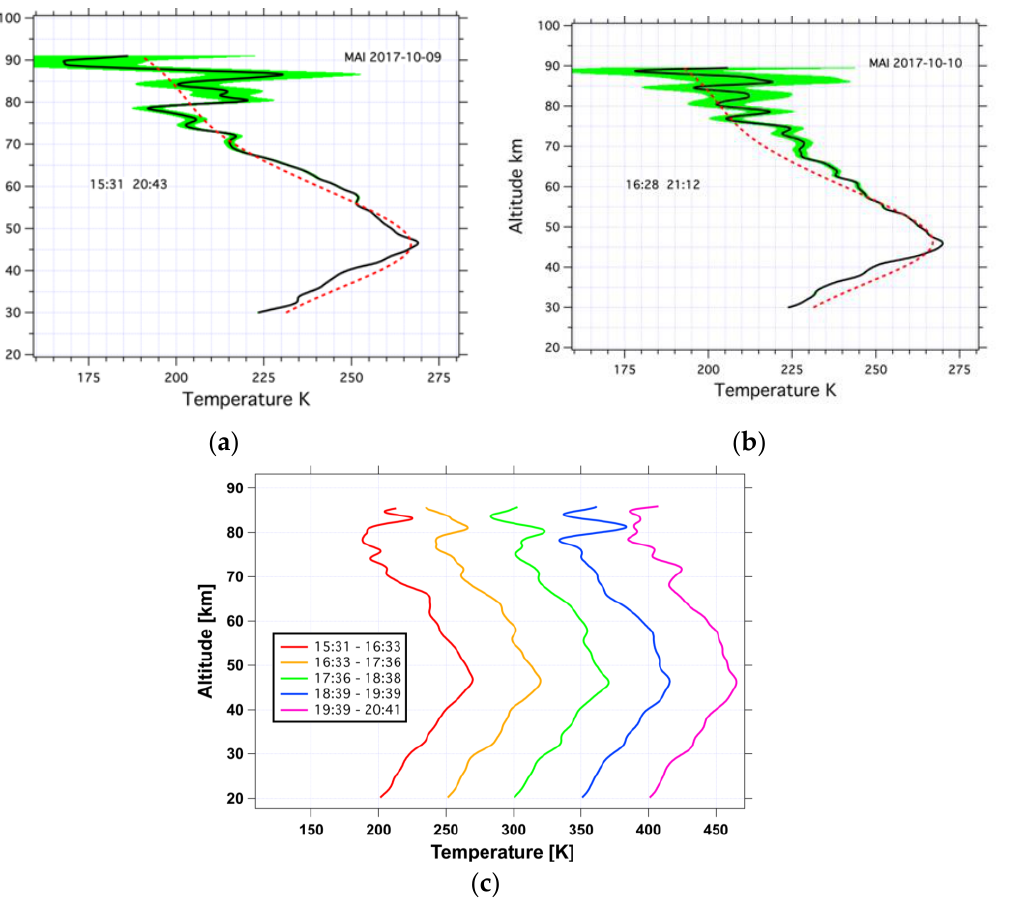
Figure 8. Lidar vertical profiles of temperature on ( a ) 9 October from 1531 UTC to 2043 UTC and on ( b ) 10 October 2017 from 1628 UTC to 2112 UTC. The black solid line represents the nightly mean profile and the green shading the statistical uncertainty (±1 standard deviation). The red dashed line indicates the NRLMSISE-00 profile for comparison. ( c ) Hourly temperature profiles on 9 October. Successive profiles are plotted with an offset of 50 K.